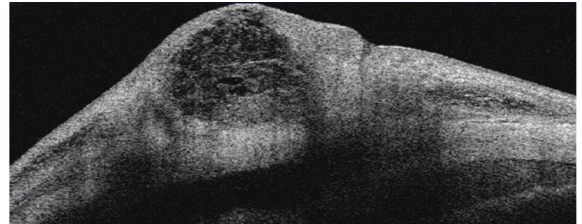
Figure 9: AS-OCT: functioning bleb after standard trabeculectomy.